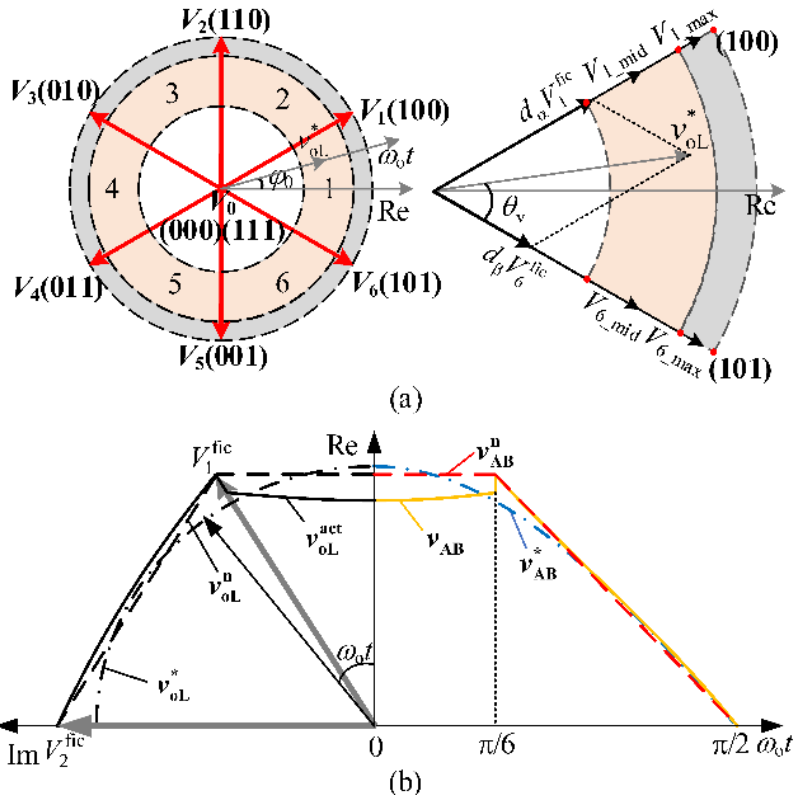
Figure 4. Diagram of space vector synthesis and trajectory of output voltage vector for the inverter stage of the IMC. ( a ) Effective space vectors and reference voltage vector synthesis; ( b ) waveform of output voltage and trajectory of the corresponding vector in the over-modulation region ( ϕ I = 0, ϕ 0 = 0, and k m = 2). effective vector V l also changes. Supposing that V l is equal to V l_ max and V l_ mid when v pn